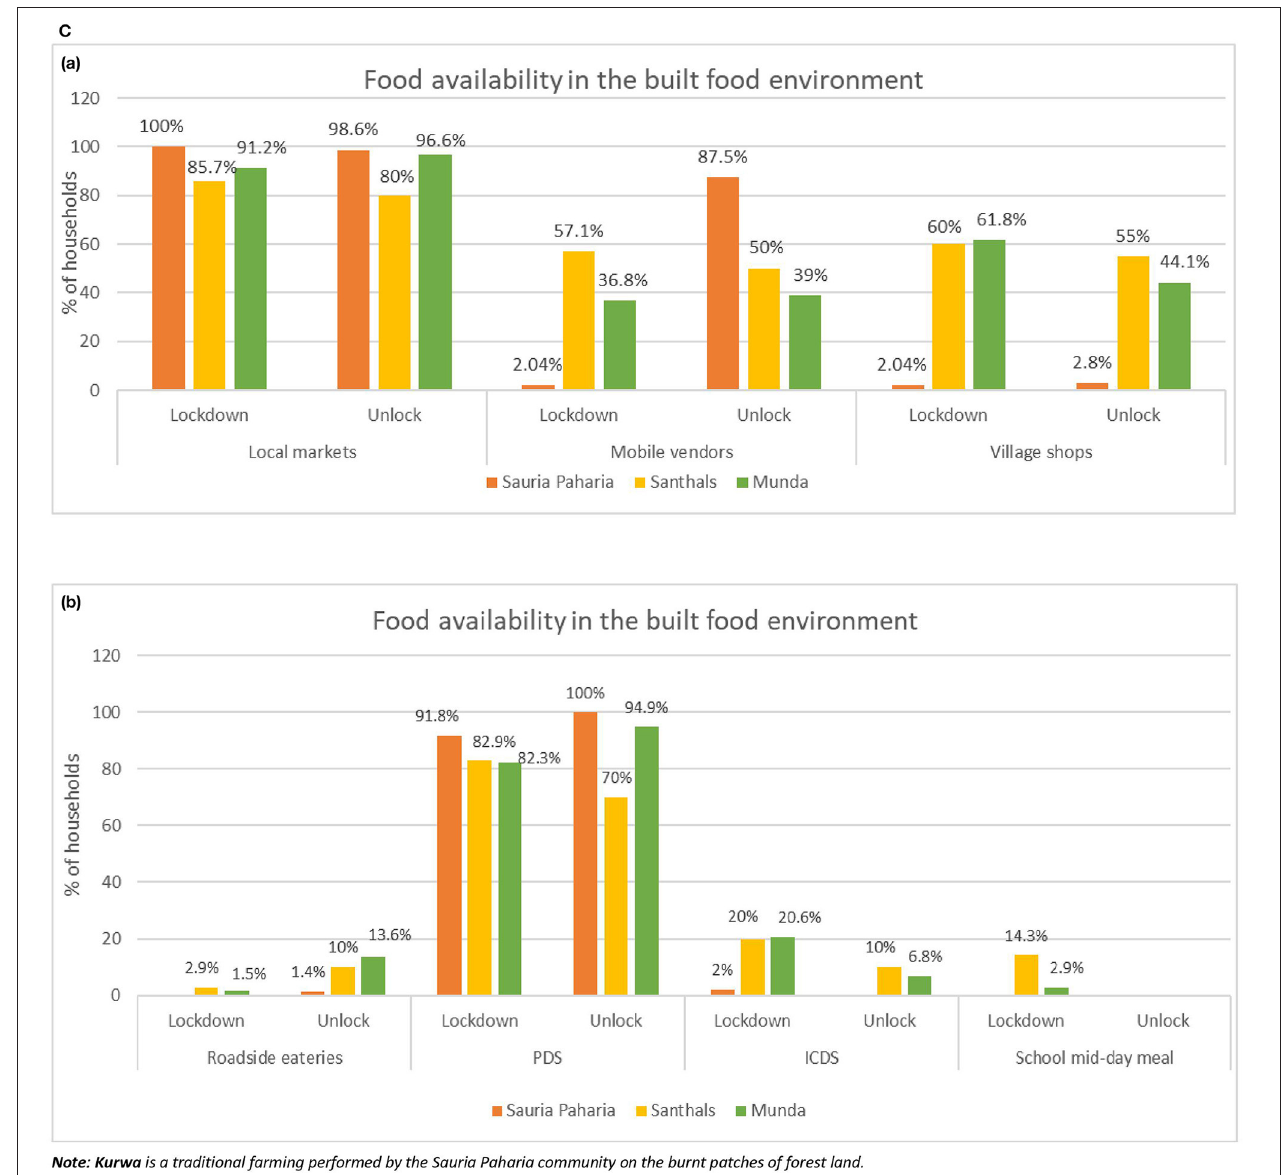
FIGURE 4 | Food environment of the indigenous communities during the COVID-19 pandemic. (A) Food availability in the wild food environment during the lockdown phase (May–June, 2020) and the unlock phase (September-October, 2020). (B) Food availability in the cultivated food environment during the lockdown phase (May-June, 2020) and the unlock phase (September-October, 2020). (C) (a,b) Food availability in the built food environment during the lockdown phase (May-June, 2020) and the unlock phase (September-October, 2020).